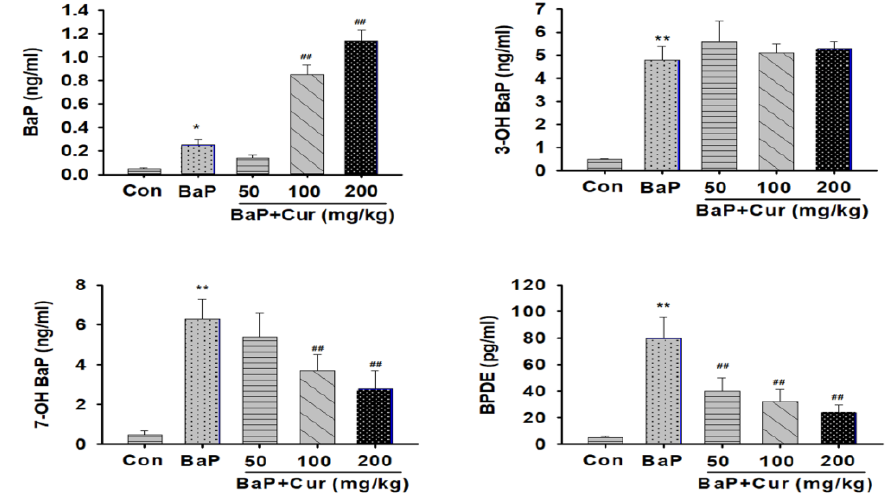
Figure 4. E ff ect of curcumin on the formation of major benzo[a]pyrene metabolites in serum of rats treated orally with benzo(a)pyrene. Rats were orally administrated benzo[a]pyrene (BaP) alone (20 mg / kg) or in combination with curcumin (50, 100, or 200 mg / kg) for 30 days. The analysis of BaP metabolite was detected using LC / MS / MS. The control group was administered vehicle only. Values are indicated by mean ± SD of six animals. Significant di ff erence from the control group at * p < 0.05; Significant di ff erence from the control group at ** p < 0.01; Significant di ff erence from the BaP alone group at ## p < 0.01. Cur: